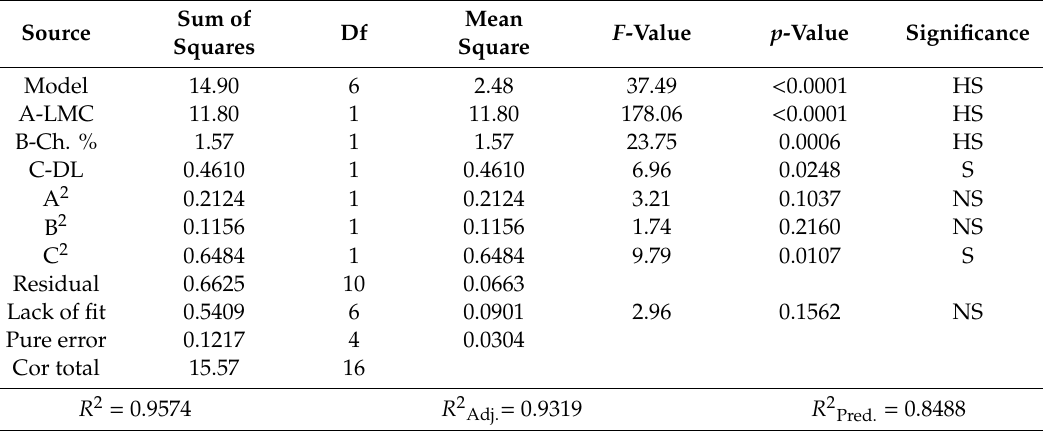
Table 3. Analysis of variance for particle size with the developed model.